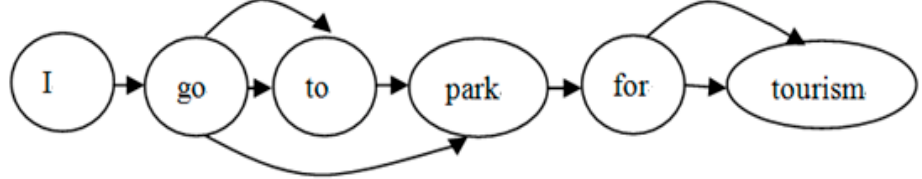
Figure 1. Example of the segmentation of a word by Jieba.